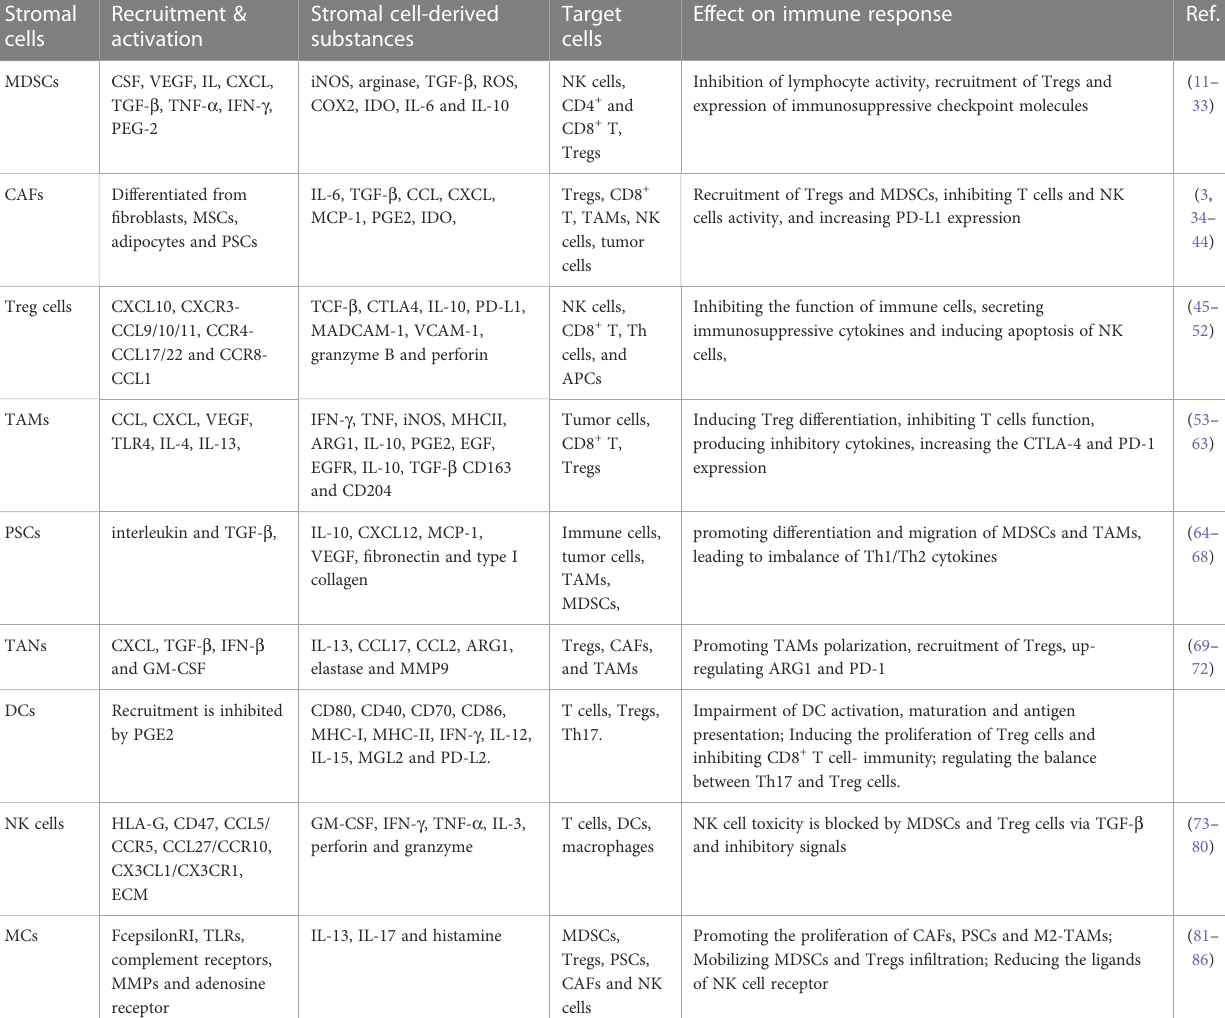
TABLE 1 The effect of stromal components in pancreatic TME on cancer immunosuppression. Stromal